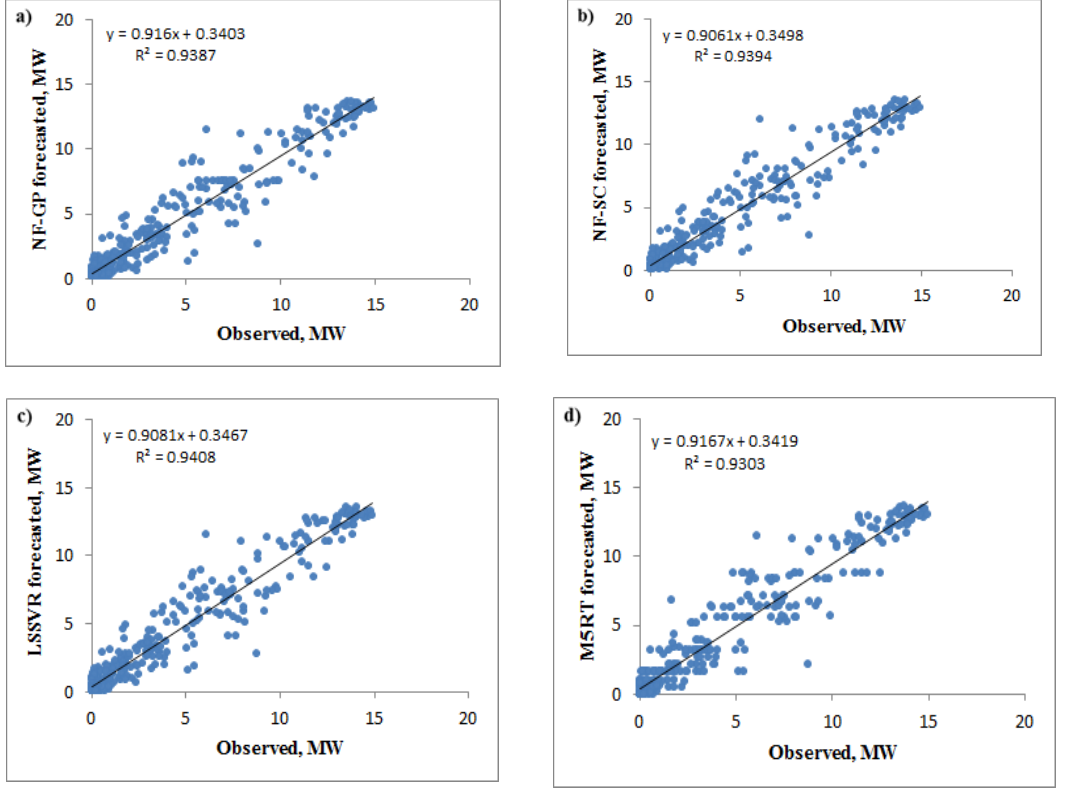
Figure 8. The scatterplots of the observed and predicted wind powers using the ( a ) NF-GP, ( b ) NF-SC, ( c ) LSSVR, and ( d ) M5RT models for the M4 dataset .